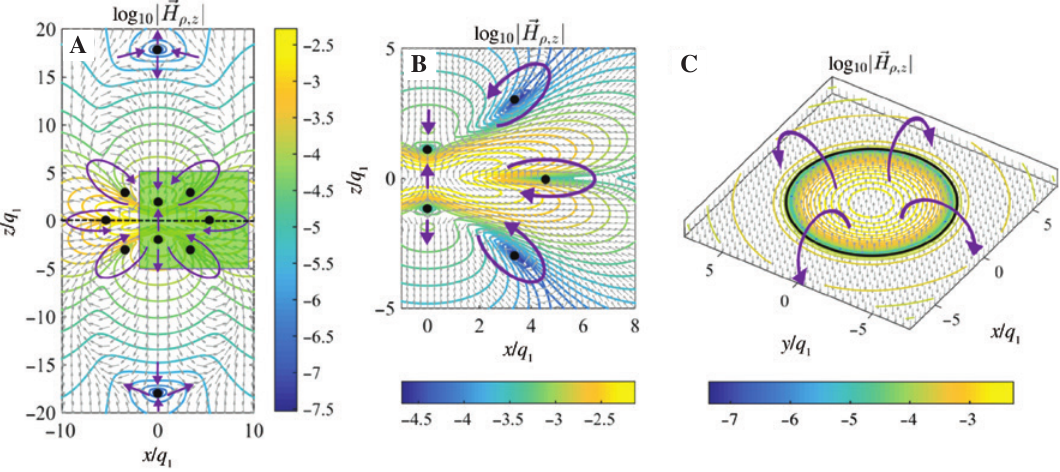
Figure 4: Magnetic field topology of the single-cycle TE FD pulse at focus. (A, B) Isoline and arrow plot of the logarithm of the magnetic field in the xz plane. Black dots indicate the zeros of the magnetic field. Panel (B) presents a zoom-in of the area highlighted by green in (A). The dashed line in (A) marks the z = 0 level at which the cross-section presented in (C) is considered. (C) Isoline and arrow plot of the logarithm of the magnetic field in the xy plane at z = 0 (dashed line in (A)). The magnetic field here vanishes along the circular solid black line. Purple arrows in all panels mark the direction of the magnetic field and serve as guide to the eye. The pulse is at focus ( t = 0) and propagates along the positive z .